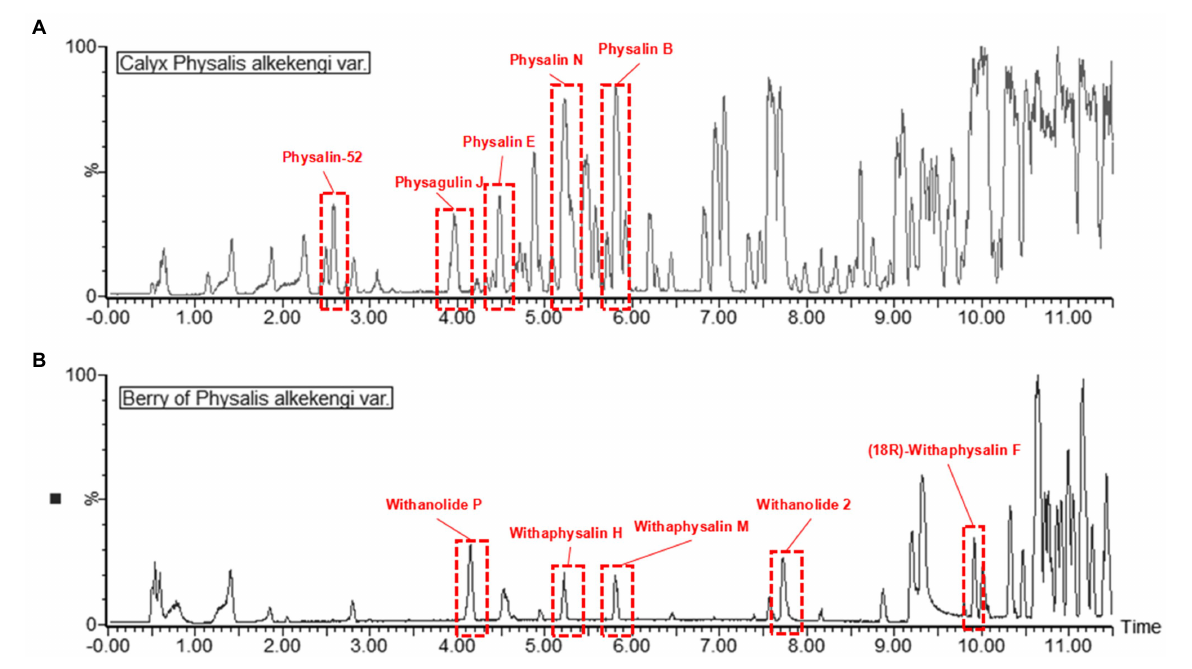
FIGURE 5 The BPI chromatograms of berry and calyx of Physalis alkekengi in positive ion mode . (A) The BPI chromatograms of calyx of P. alkekengi . (B) The BPI chromatograms of berry of P.